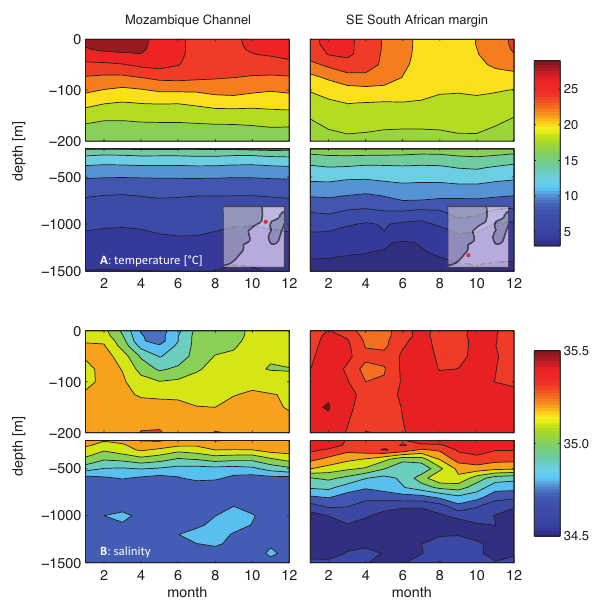
Fig. 1: Monthly averaged temperature (A) and salinity (B) for the Mozambique Channel and SE South African margin sites. Map insets show location of the sites (see also table 1). Note the difference in scale for the upper 200 m. Data from World Ocean Atlas 2009 from the ¼ degree grid cells closest to the sites; the SE South African Margin panels show averaged values for all sites (Antonov et al., 2010; Locarnini et al., 2010).